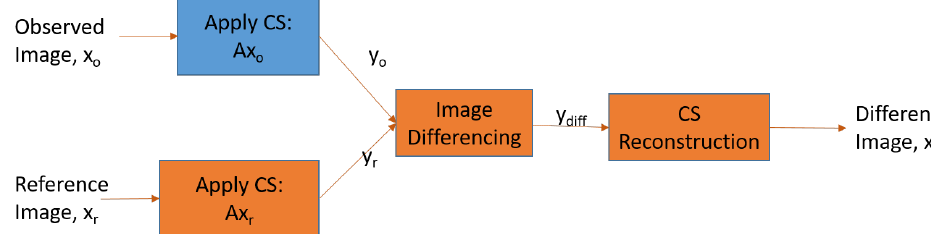
Figure 1. CS architecture. The blue block represents CS data acquisition, which can be performed on-board a spaceflight instrument, while the orange blocks represent computations, which can be performed on the